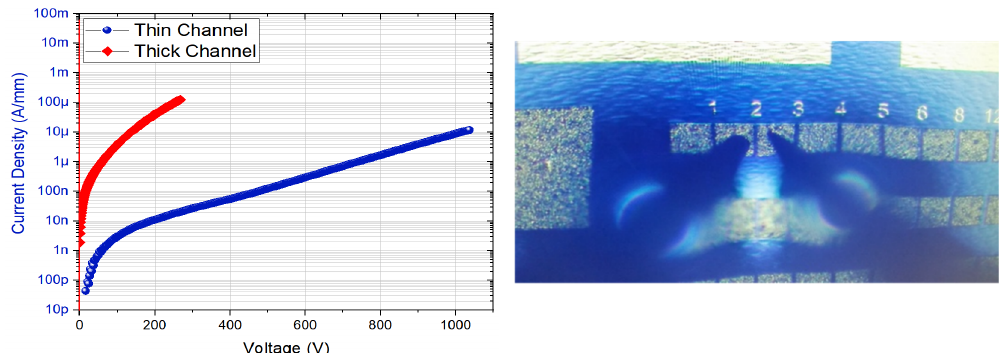
Figure 3. Lateral breakdown voltage at Room Temperature on isolated contacts with a 2 µm distance of thin and thick channel structures. The probes that were emerged in a Fluorinert solution on top of the contacts are also shown.